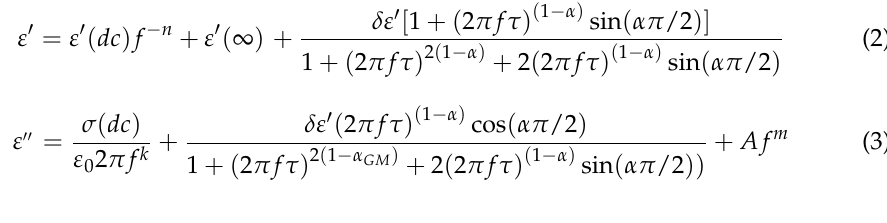
frequency at 0 volt applied bias and 56 ◦ C temperature for pure nematic MBDA and its mixture with core/shell quantum